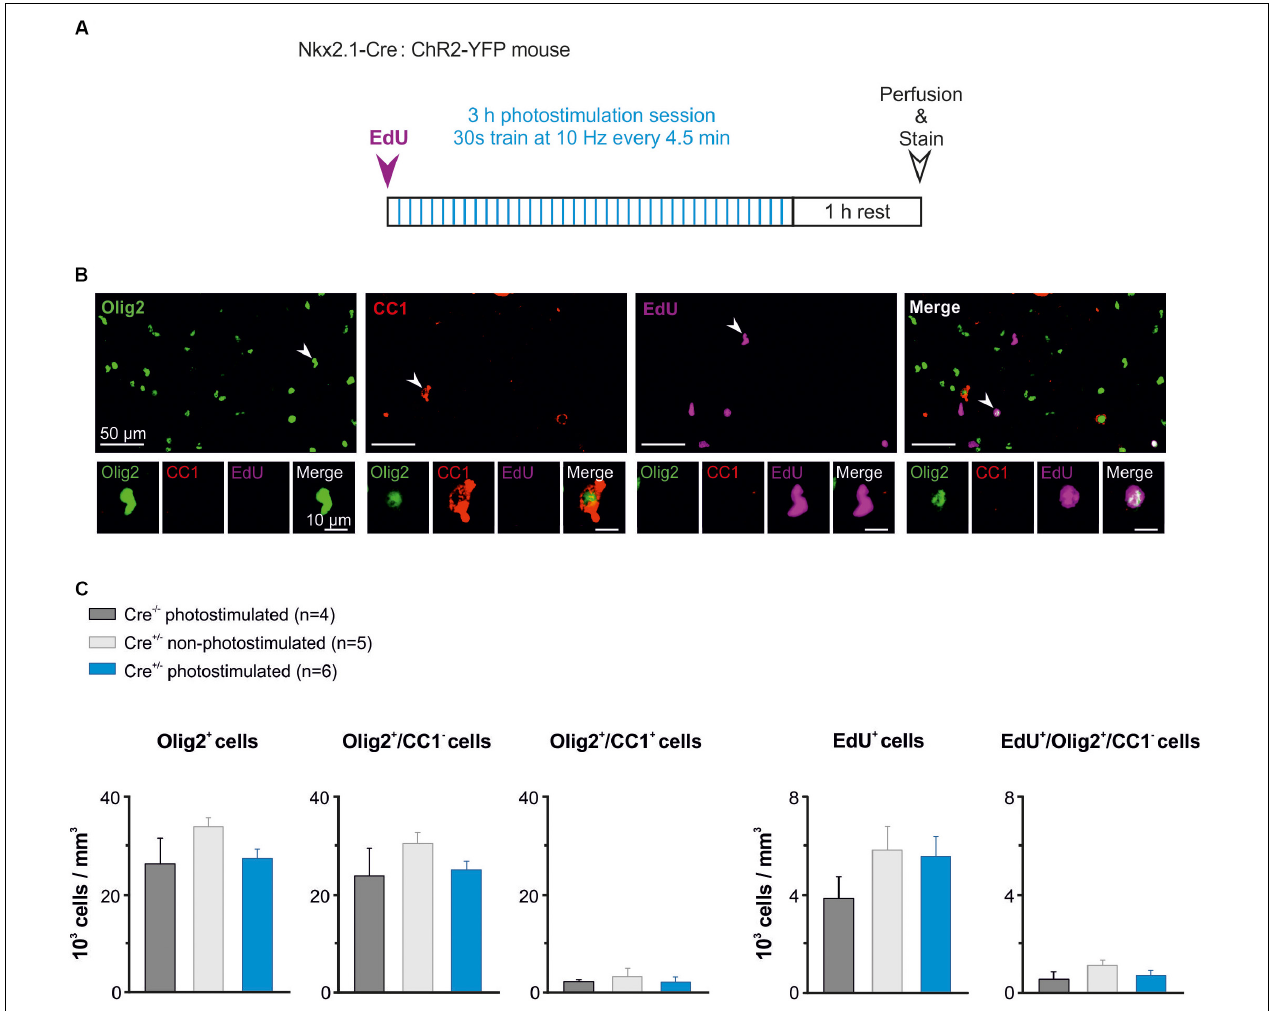
FIGURE 6 | The in vivo photoactivation of layer V cortical interneurons at P10 does not modify oligodendroglia density. (A) Experimental design for a photostimulation protocol. Mice were injected with EdU (50 mg/kg) and then photostimulated during 3 h. (B) Olig2 (green), CC1 (red) and EdU (magenta) cells stained after the photostimulation session. An Olig2 + /CC1 − OPC is indicated in the first panel (arrowhead, insets). Only few Olig2 + /CC1 + OLs were found at this age (arrowhead in second panel, insets). Note that not all EdU-stained cells were Olig2 + cells (arrowheads in the last two panels). (C) Density of total oligodendroglia (lig2 + ), OPCs (Olig2 + /CC1 − ), differentiated OLs (Olig2 + /CC1 + ), total proliferative cells (EdU + ), and proliferative OPCs (Edu + /Olig2 + /CC1 − ) in the three tested conditions. No significant differences were found for any comparison ( p > 0.05, Kruskal–Wallis Test followed by a Dunn’s post hoc